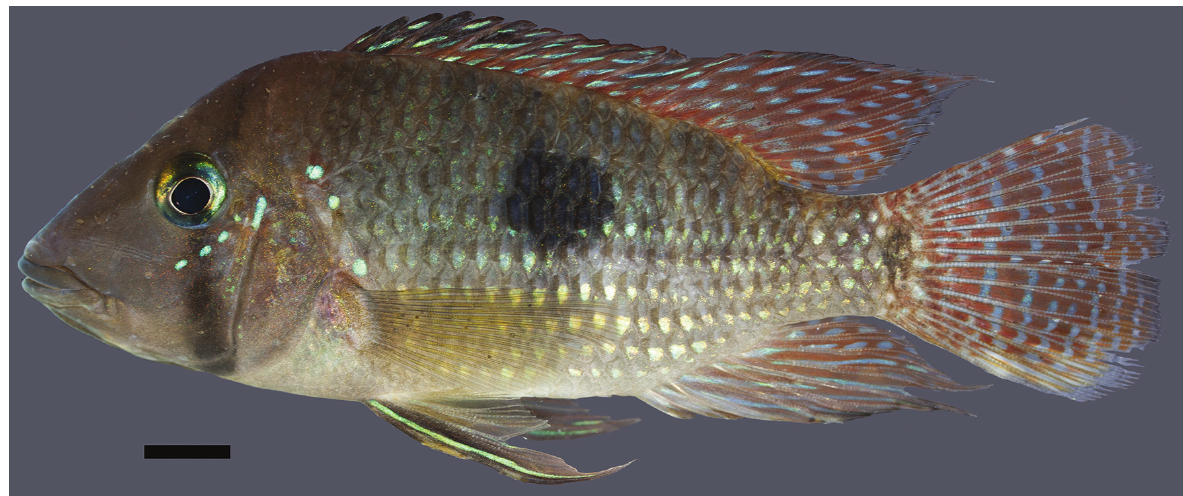
Figure 4. Geophagus multiocellus , UFRJ 11764, holotype, 101.4 mm SL; Brazil: Bahia: Rio de Contas Basin. Scale bar 10 mm. Photograph by J.L.O.